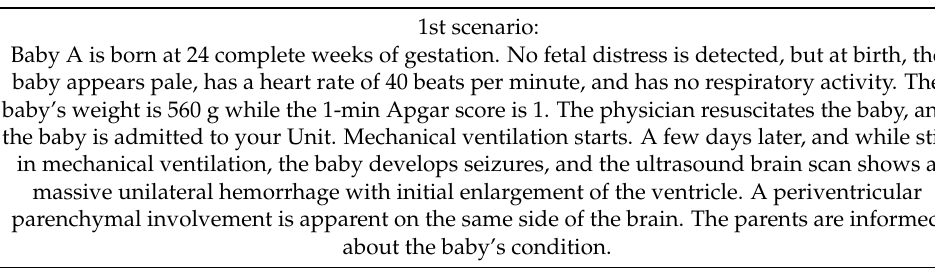
Table 1. The three hypothetical